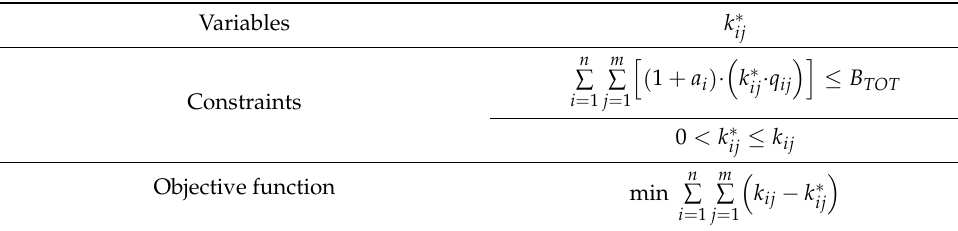
Table 1. The optimization